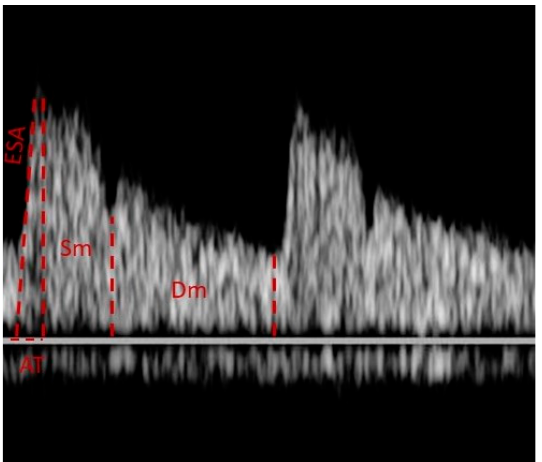
Figure 2. The Doppler waveform of OA. “ESA” corresponds to the inclination of the fastest-moving part of the systolic phase and “AT” to the duration of the above inclination. The “Ratio Sm/Dm” represents the ratio of the mean velocities of the systolic and diastolic phases.